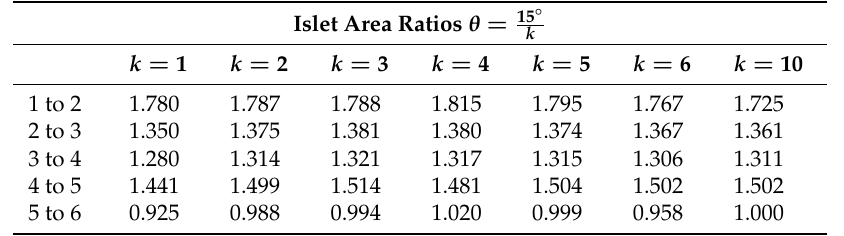
deviation was found by averaging the standard deviation found for each row of data.